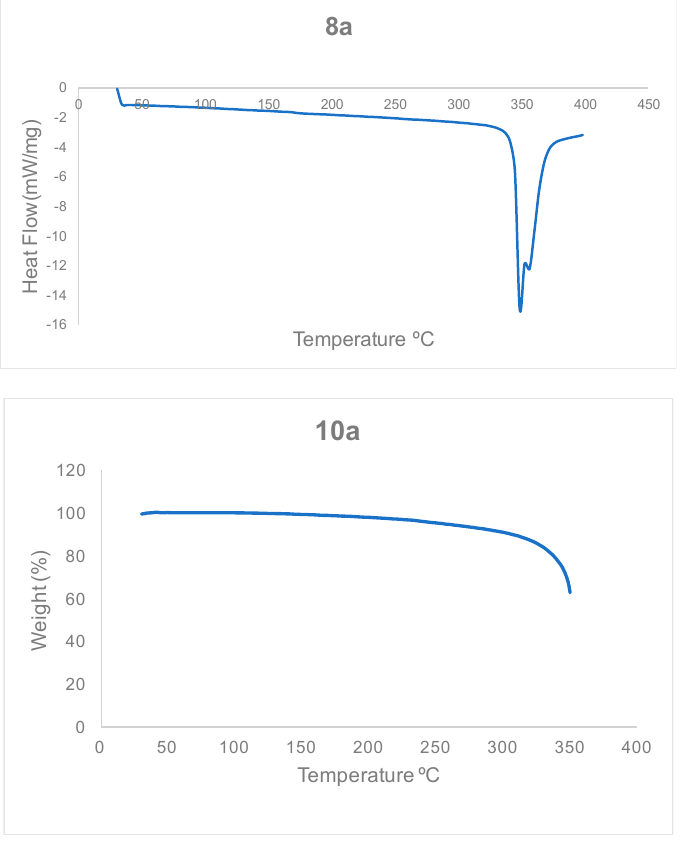
Figure 7. Differential scanning calorimetry (DSC, top) of 8a . Thermogravimetric analysis (TGA, down) of 10a .